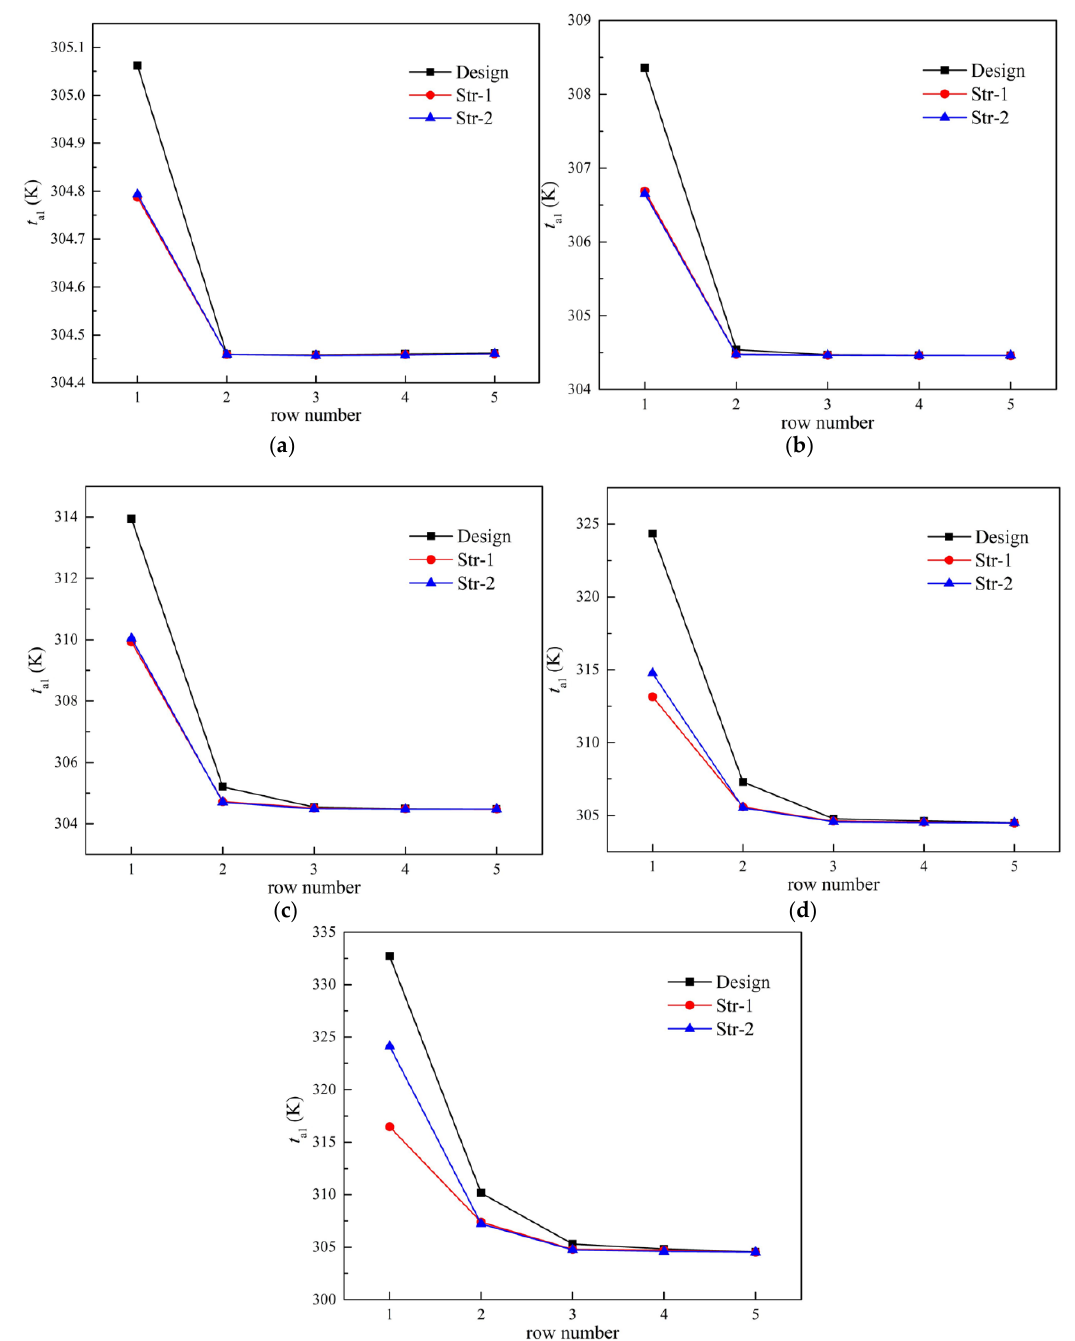
Figure 9. Average inlet air temperatures of fans in each row for Design, Str-1, and Str-2 cases at different wind speeds: ( a ) 4 m/s; ( b ) 8 m/s; ( c ) 12 m/s; ( d ) 16 m/s; ( e ) 20 m/s.